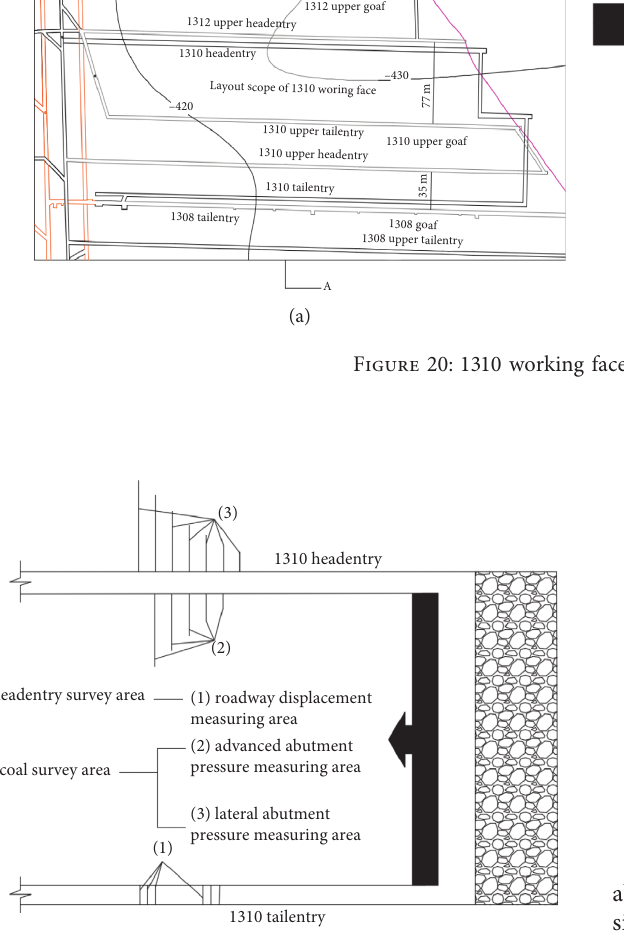
Figure 21: Layout of survey area.